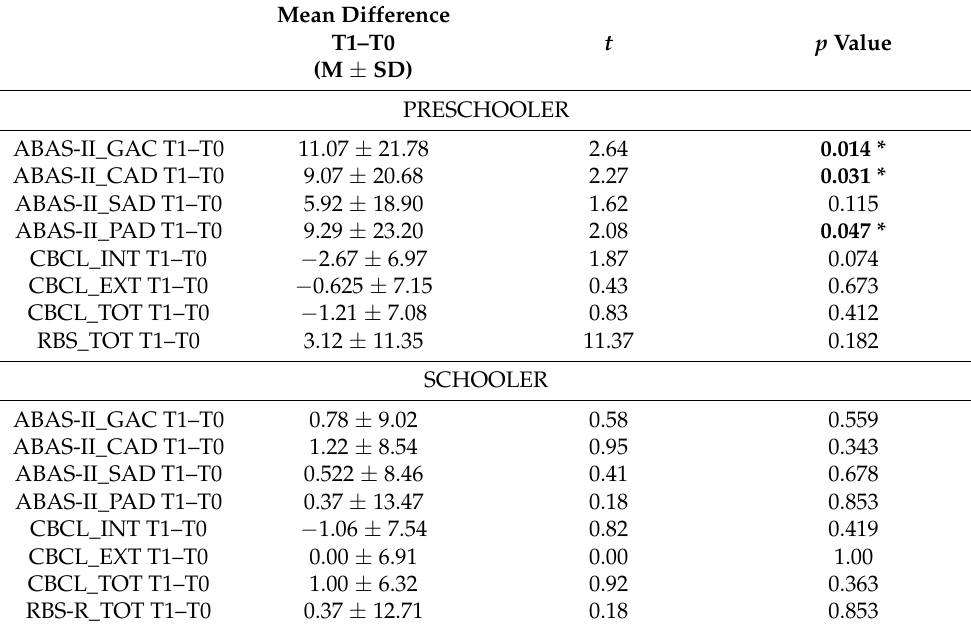
Table 2. Paired differences between T1 (after the end of lockdown; re-opening phase) and T0 (before